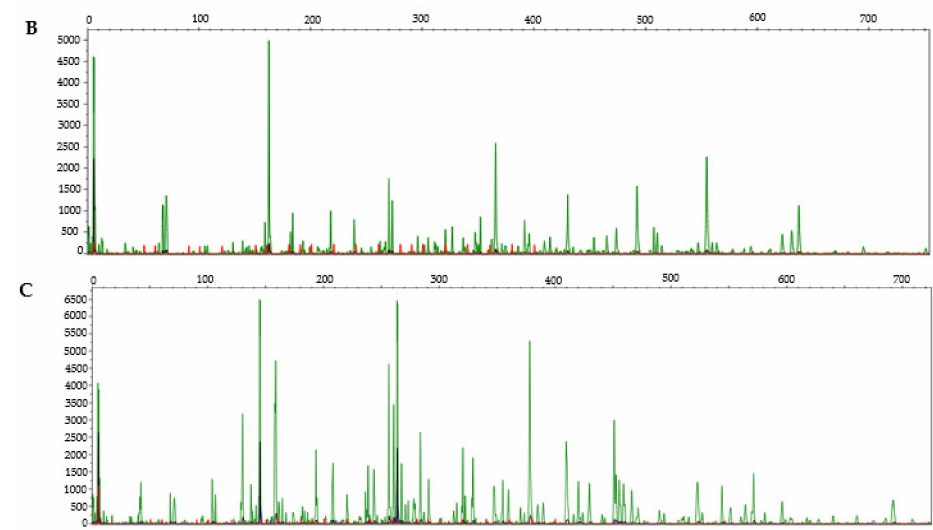
Figure 3. Examples of MSAP polymorphisms in electropherograms corresponding to Q. ilex adult tree leaves ( A ), embryos ( B ) and seedling leaves ( C ) using MspI + EcoRI digestion and the primer combination EcoRI + ACG and MspI +